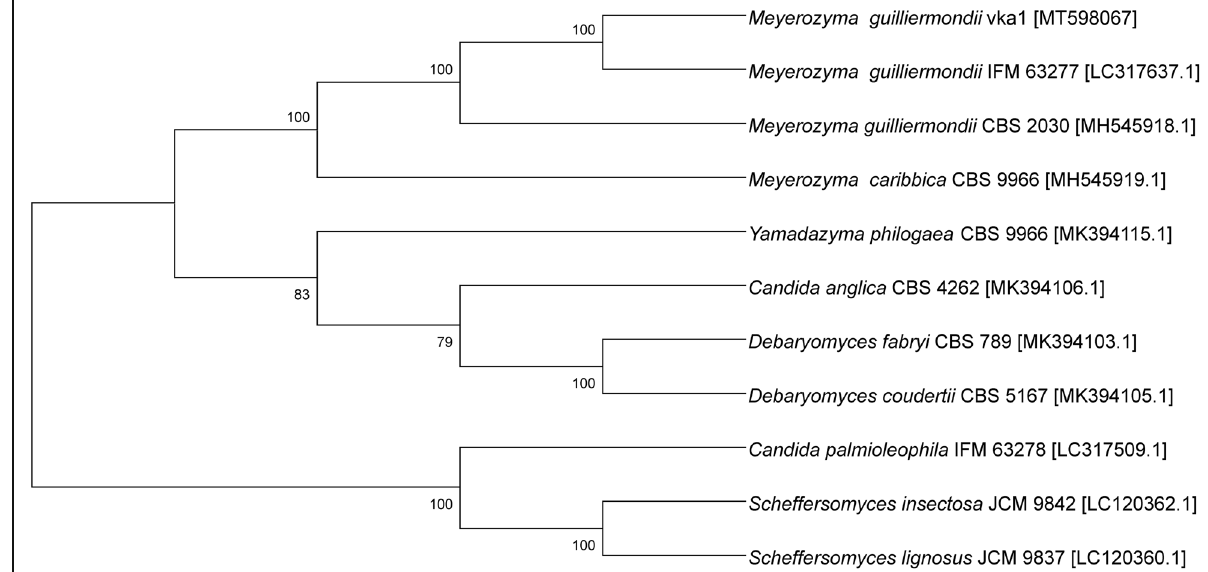
Fig. 2 Phylogenetic relationships (cladogram) based on the sequences of rDNA region from selected genomes, inferred using the Neighbour Joining (NJ) method. The percentages of replicate trees in which the associated taxa clustered together in the bootstrap test (1000 replicates) are shown next to the